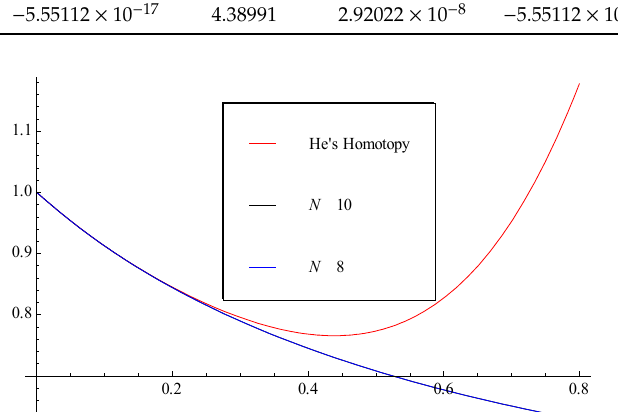
Figure 5 . Approximate solution